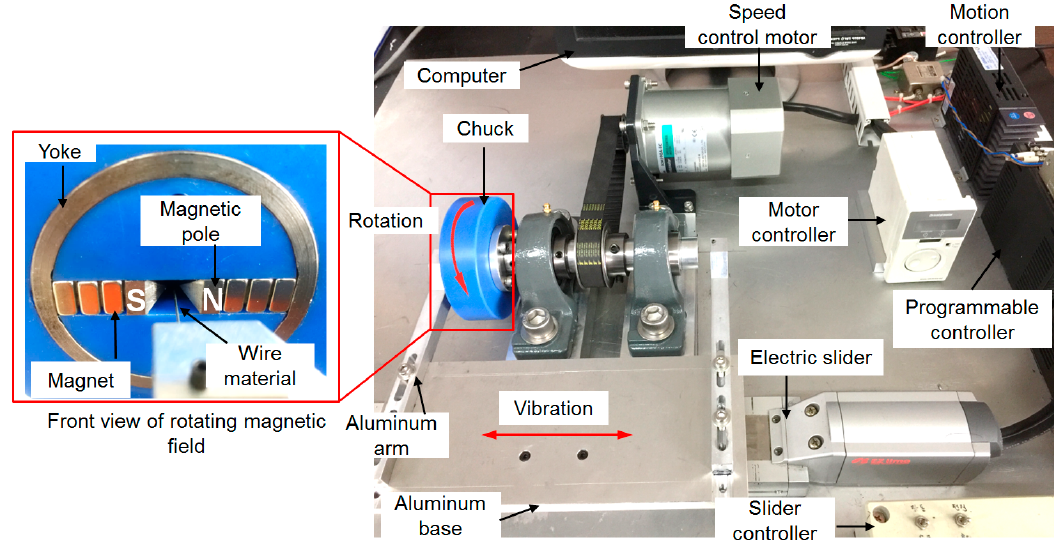
Figure 4. Experimental setup of ultra-high-precision magnetic abrasive finishing process.